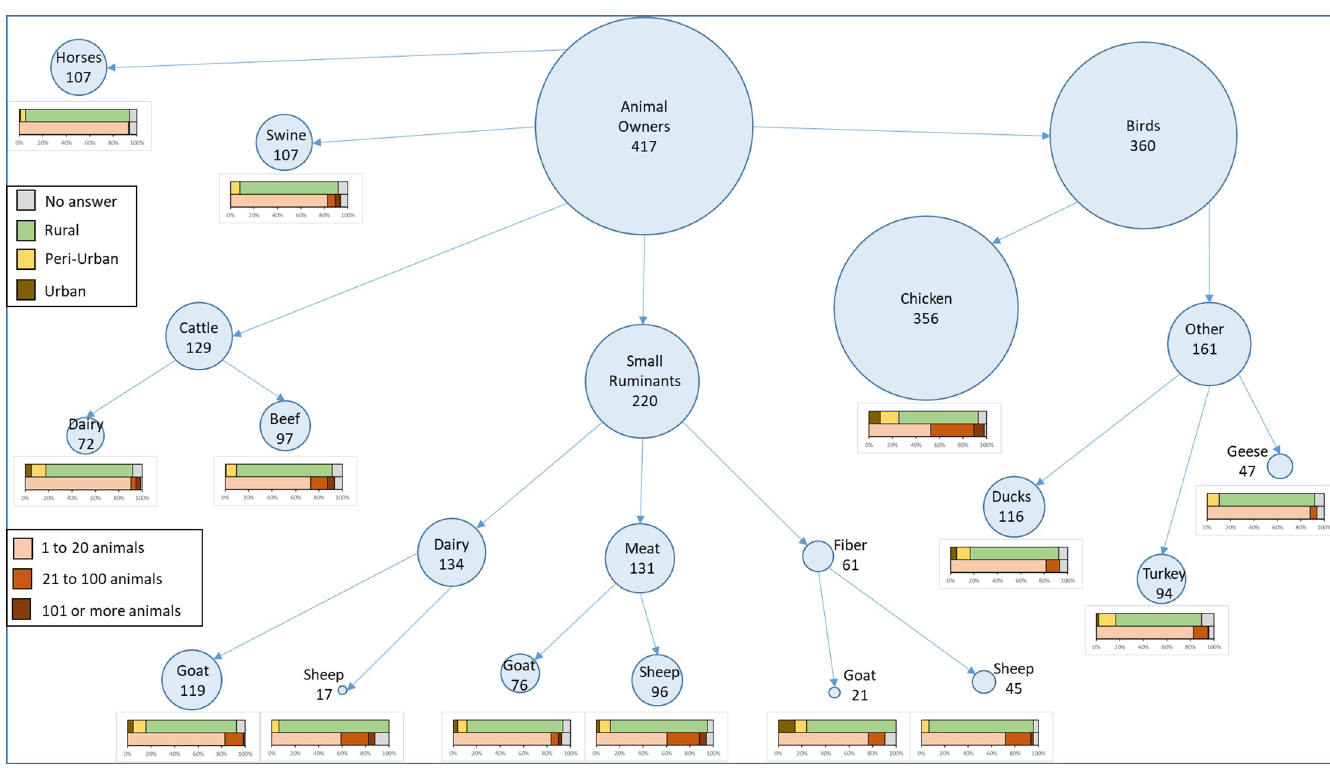
Fig 2. Number of small-scale livestock and poultry owners (n = 417) owning each type of animal (birds, cattle, small ruminants, swine and horses), herd size and settings (urban, peri-urban and rural) by type of animal.